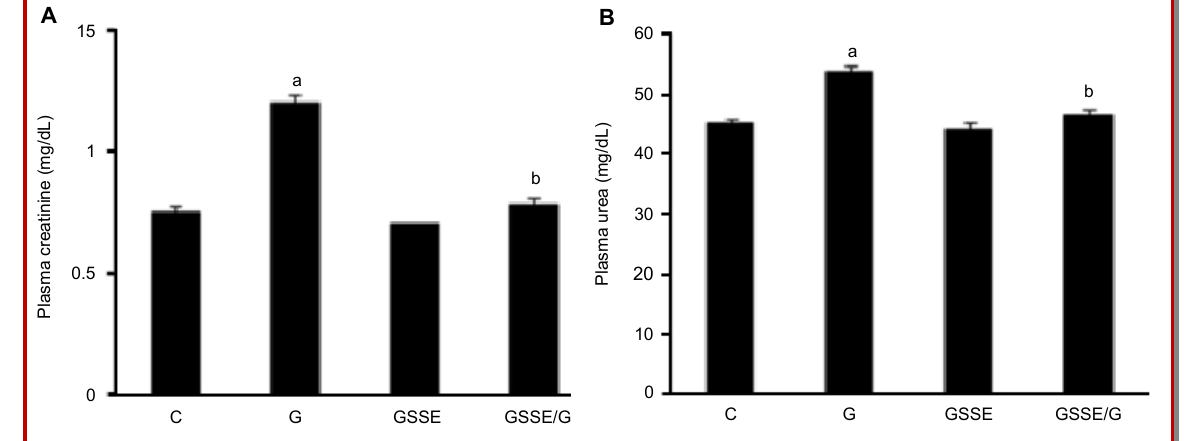
Figure 1: Effect of garlic and GSSE on plasma creatinine and urea. 10% ethanol (C), garlic (G), grape seed and skin extract (GSSE) or garlic plus GSSE (GSSE/G) were administered to rats for 1 month and plasma cratinine (A), and urea (B) were deter- mined. Results are expressed by mean ± SEM (n= 10). a p<0.01 vs C. b p<0.01 vs G